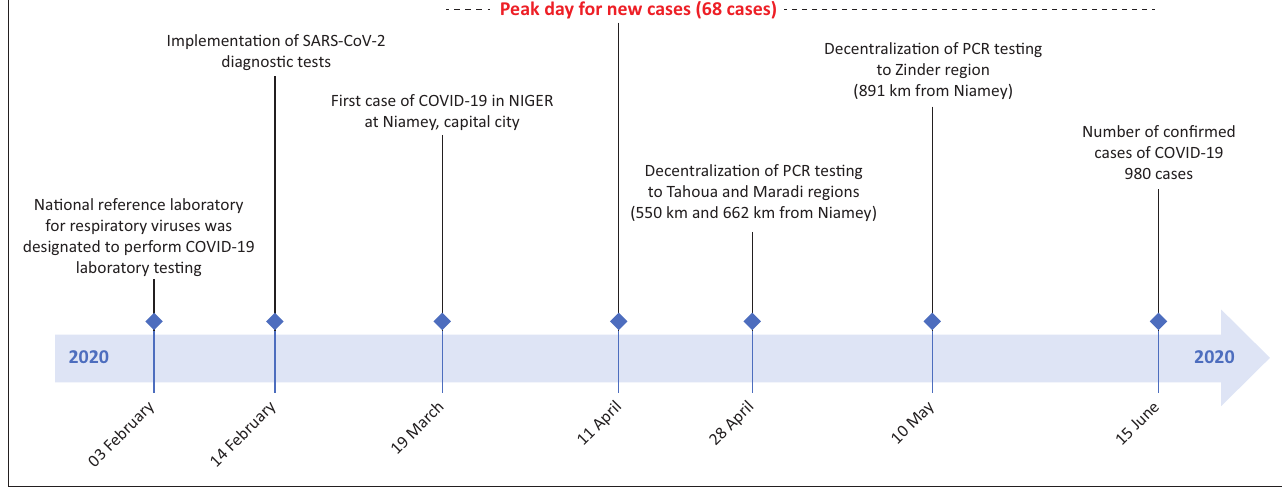
COVID-19, coronavirus disease 2019; PCR, polymerase chain reaction; SARS-CoV-2, severe acute respiratory coronavirus-2. FIGURE 1: Laboratory organisation and adaptation for COVID-19 pandemic in Niger. The 68 cases (in red) recorded on 11 April 2020 denote the peak between 19 March 2020 (index case) and 15 June 2020.